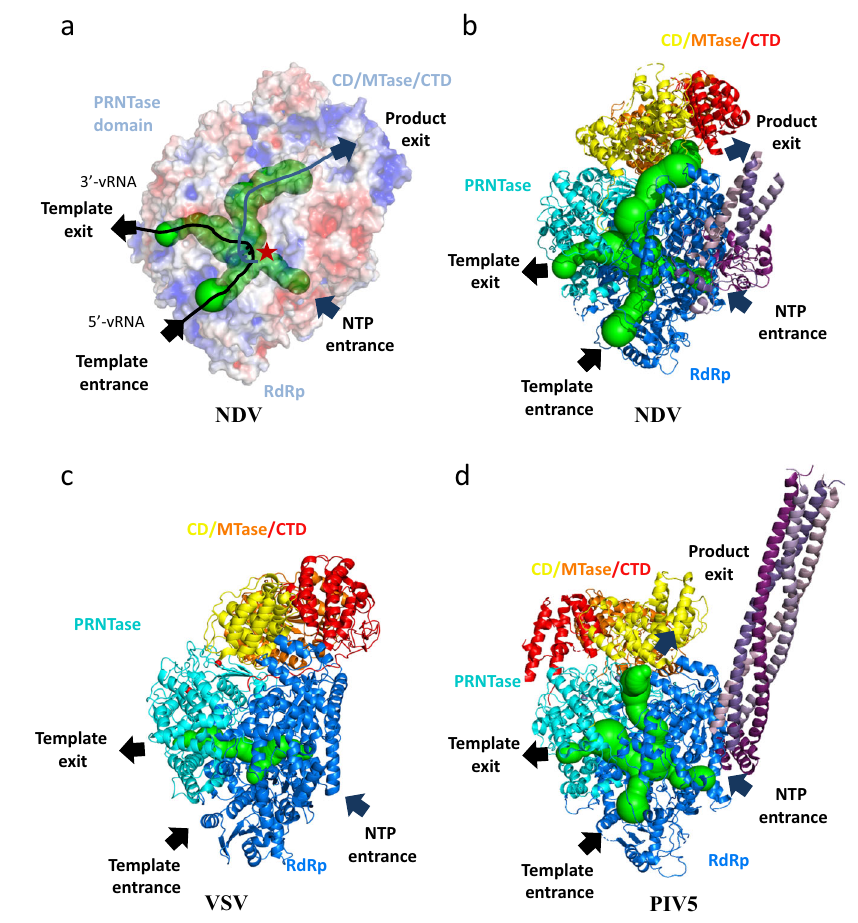
Fig. 6 | Structural comparison of NDV, VSV and PIV5 L-P complexes. a Tunnels withintheNDVL-PstructureforRNAsynthesis.Thetemplateentranceandexit,the NTPentranceandproductexitareshown. b – d ComparisonoftheNDV b ,VSV c ,and